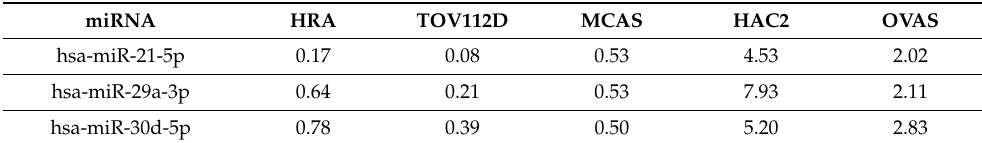
Table 3. Detection of exosomal miRNAs overexpressed in CCCO (expression rate compared to normal cells is